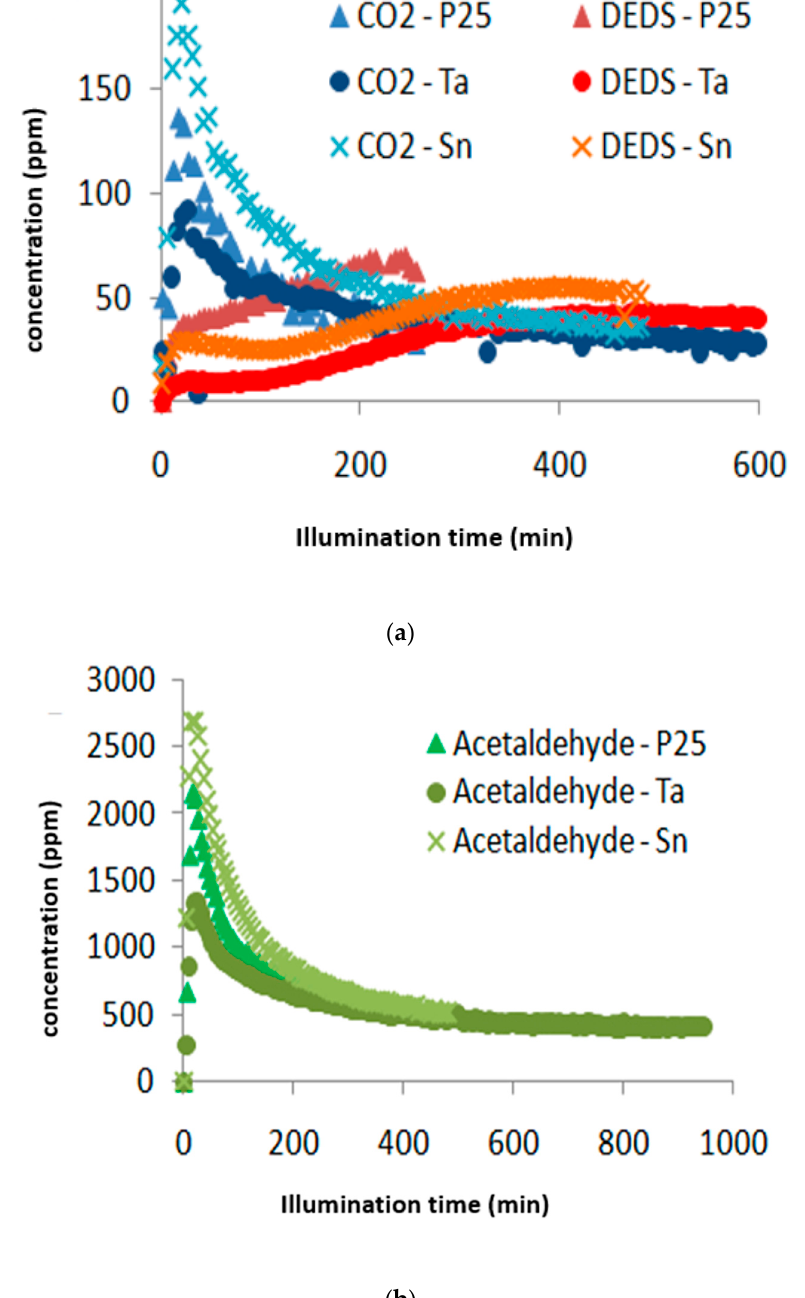
Figure 10. By-products evolution (CO 2 and DEDS in ( a ), acethaldehyde in ( b )) during photo-oxidation of DES with TiO 2 - P25 and Ta/Sn doped TiO